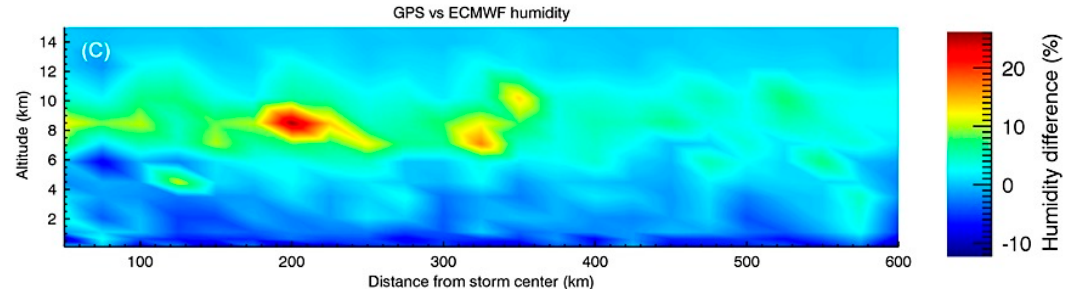
Figure 13. TC relative humidity fractional di ff erence between GPS simulation and ECMWF reanalysis. As the vertical profile of the TC, the humidity is statistically analyzed as a function of the altitude and distance from the eye of the cyclones. The relative humidity of the simulated rain bands 200 km from the center is approximately 25% higher than ECMWF reanalysis [63].